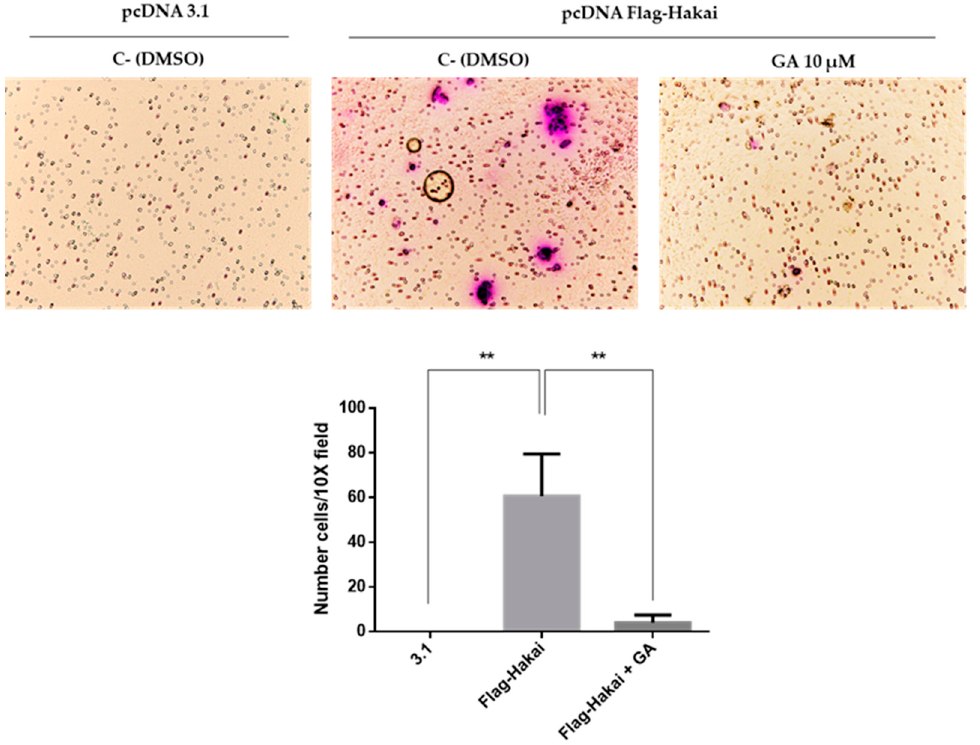
Figure 8. Geldanamycin reduces Hakai-induced cell migration: HEK293T cells were transiently transfected with 8 µ g of empty vector pcDNA 3.1 or pcDNA-Flag-Hakai for 54 h and motility was evaluated by transwell migration assay in presence or absence of 10 µ M geldanamycin. Cells were seeded into migration transwells 48 h after transfection and let to migrate for 16 h in a gradient concentration of FBS (1–30%). Then cells were fixed and stained as indicated in methods. Images were obtained by optical microscopy with an objective of 10X magnification. Representative images taken using the 10 × objective are shown ( upper panel ) and quantification of migrating cells is shown ( bottom panel ). Results are represented as as Mean ± SEM of triplicates (** p < 0.01). 2.6. Hsp90 Is Highly Expressed in Colorectal Cancer Samples Compared to Adjacent Normal Epithelial